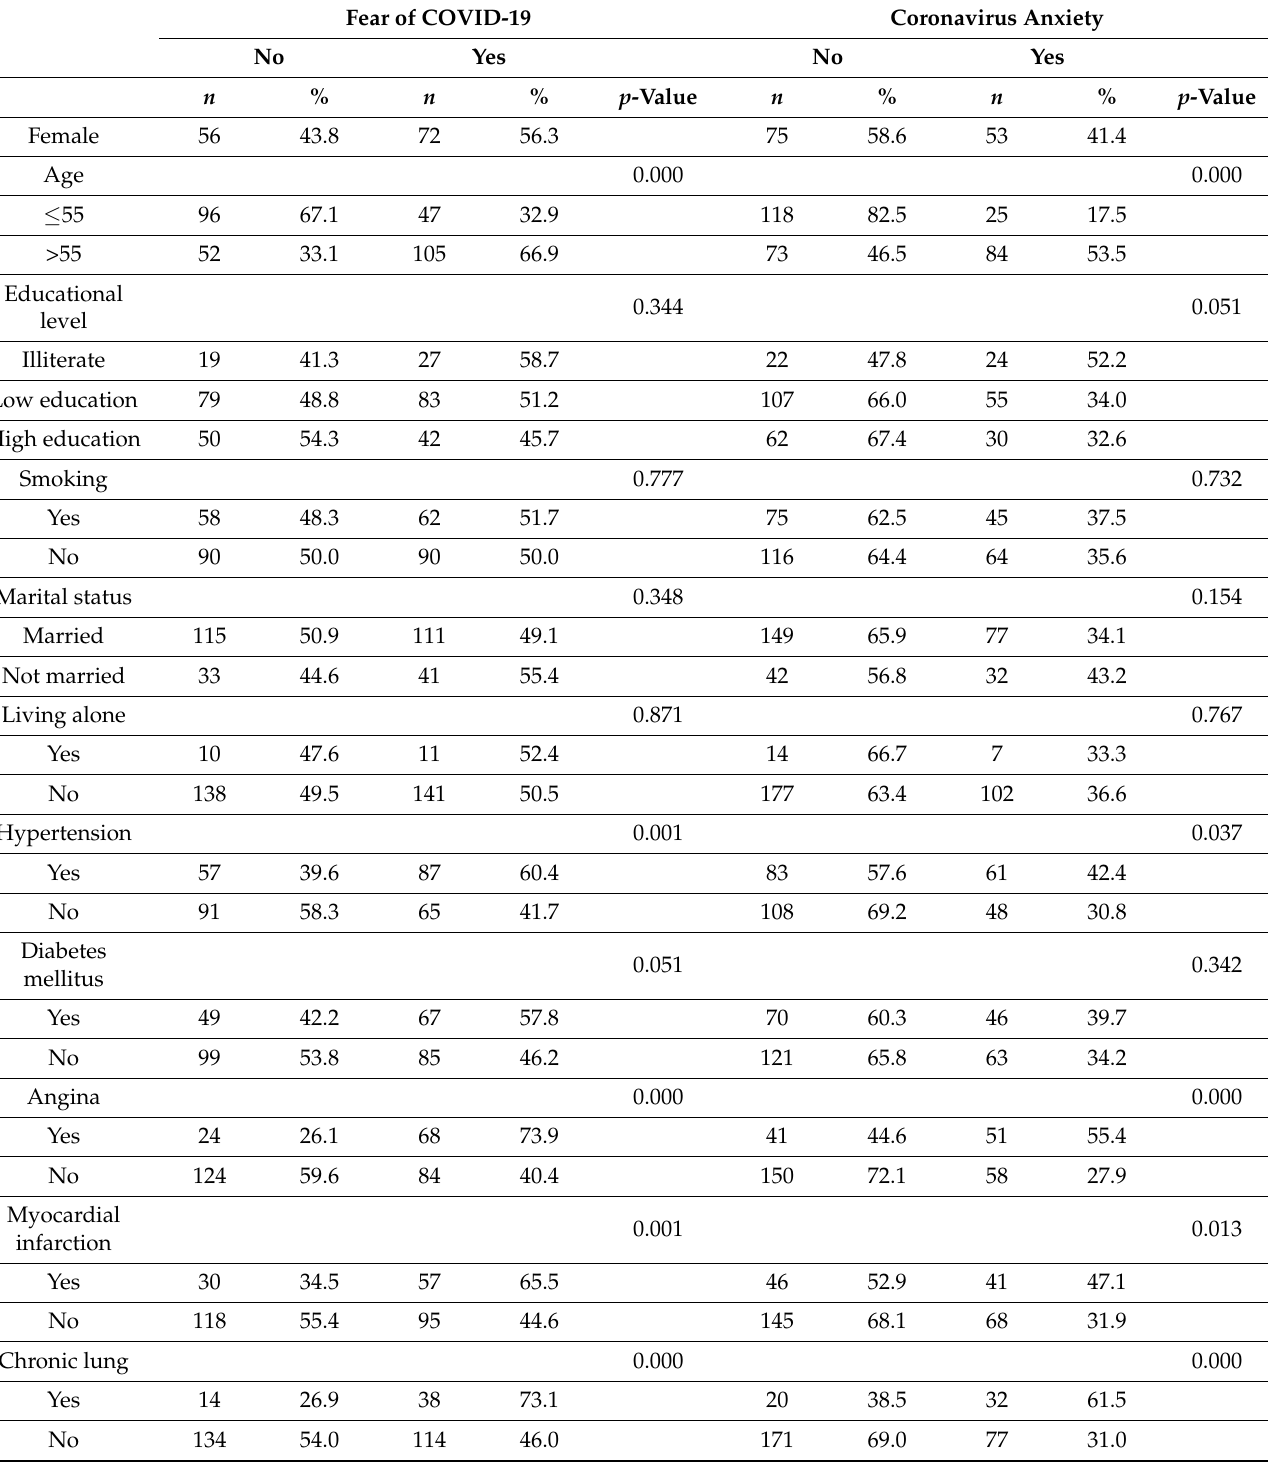
The proportion of patients who had coronavirus anxiety was significantly higher among patients aged over 55 years compared to younger patients (53.5% vs. 17.5%), patients with hypertension (42.4% vs. 30.8%), angina (55.4% vs. 27.9%), myocardial infarction (47.1% vs. 31.9%), and chronic lung disease (61.5% vs.